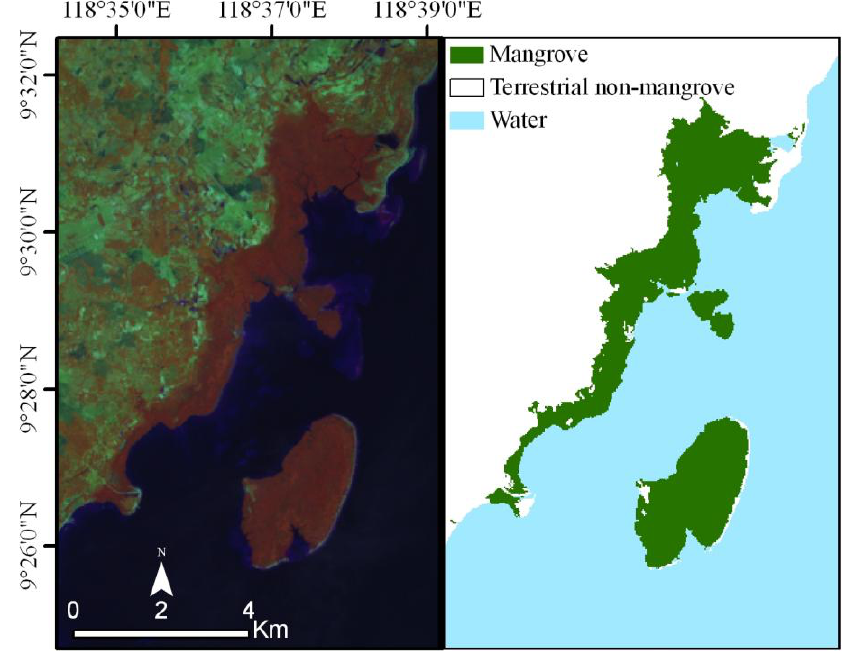
Figure 4. Landsat satellite image including mangrove forest cover ( left ) on Palawan Island, Philippines, compared with classification results ( right ). Intact mangrove forest is relatively distinct and appears bright orange in false color band combination 4, 5, and 7